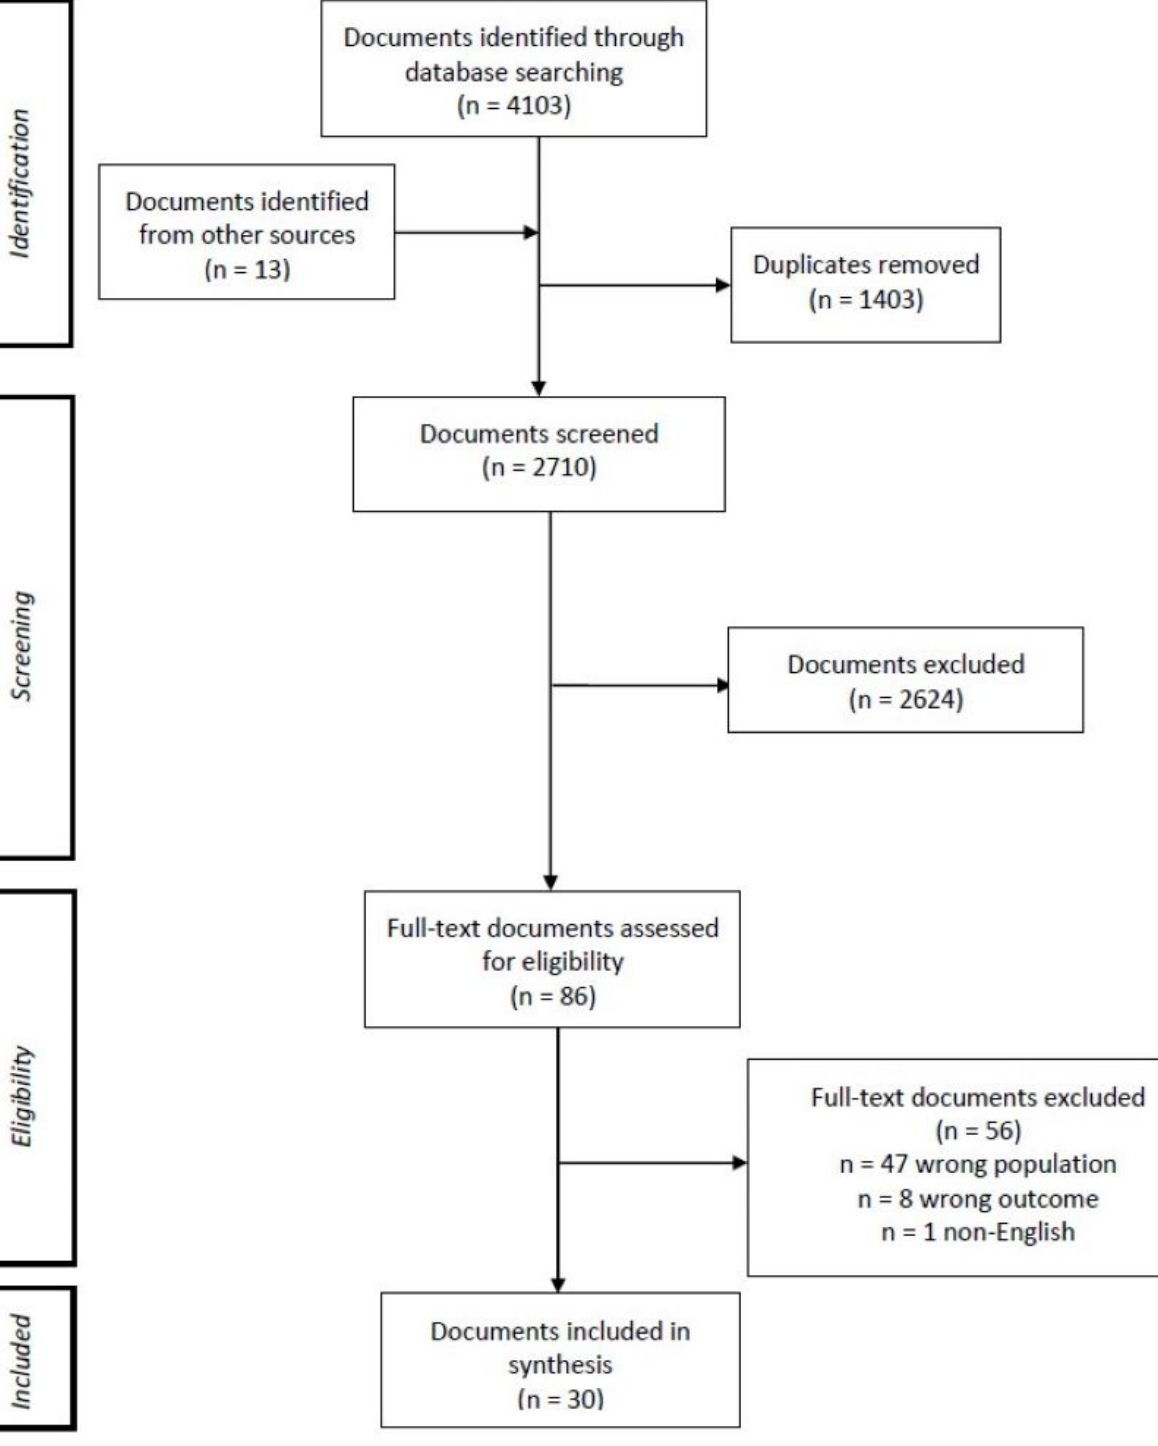
Figure 2. Study flow diagram